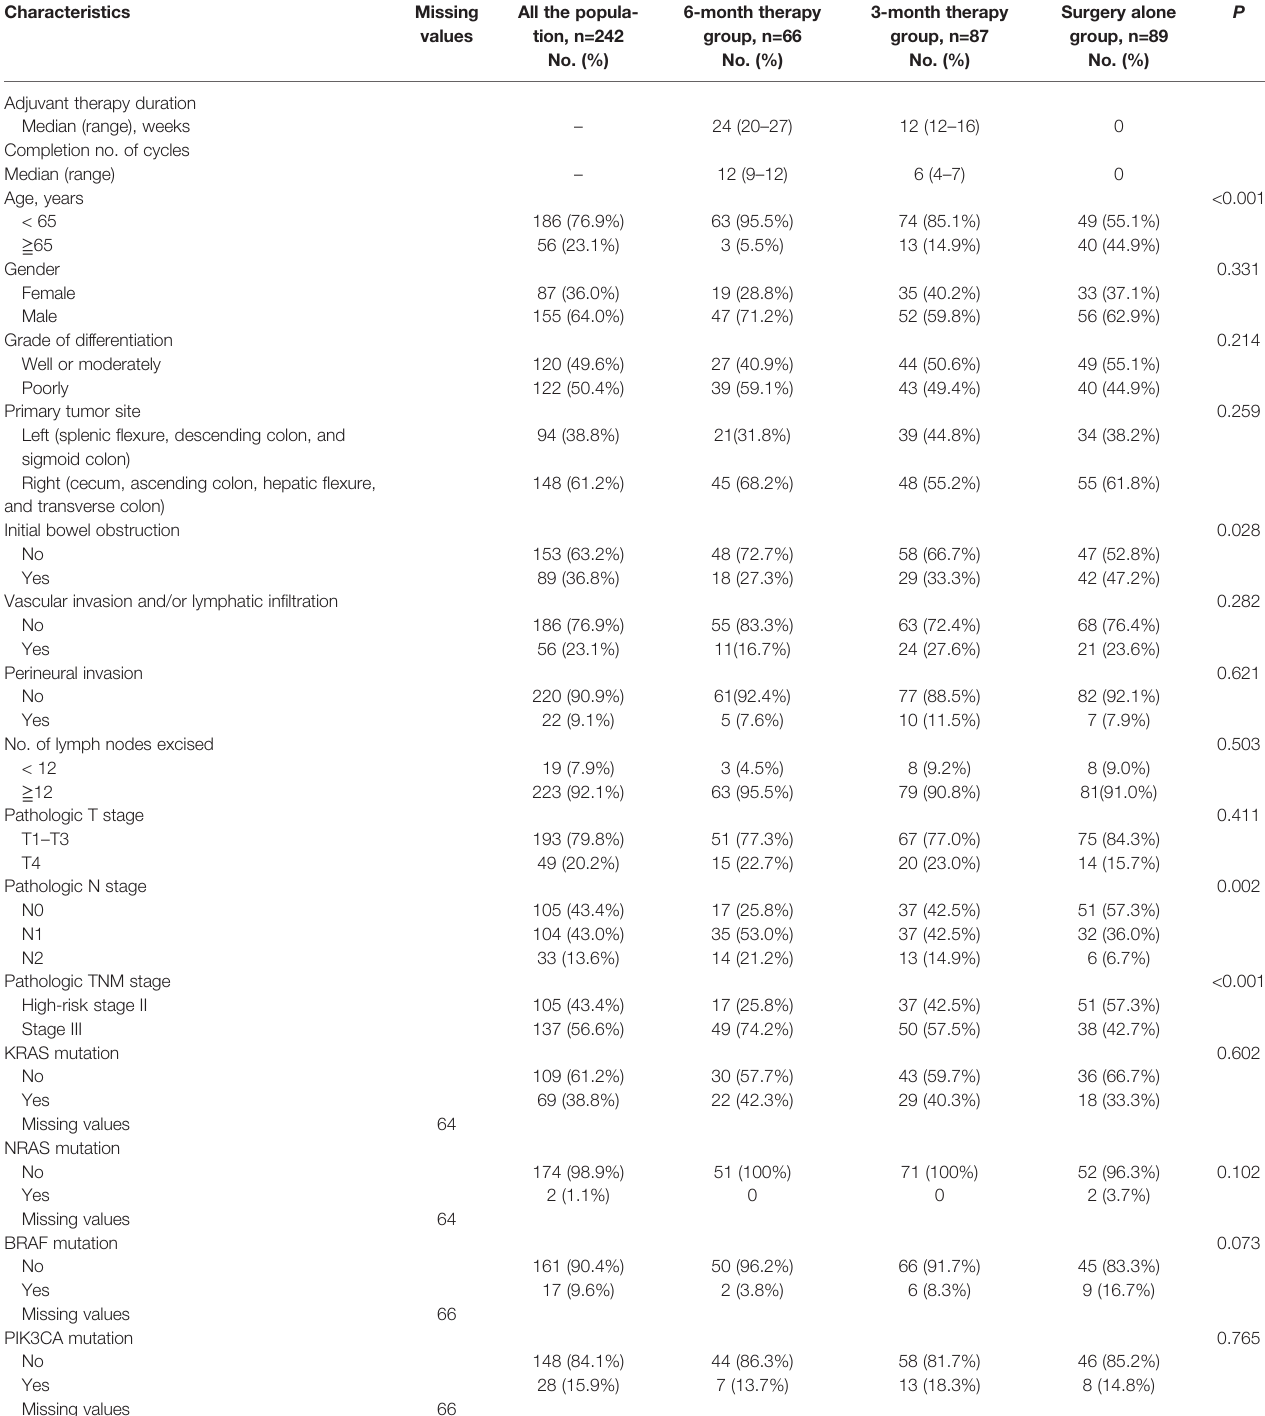
TABLE 1 | Patients and tumor